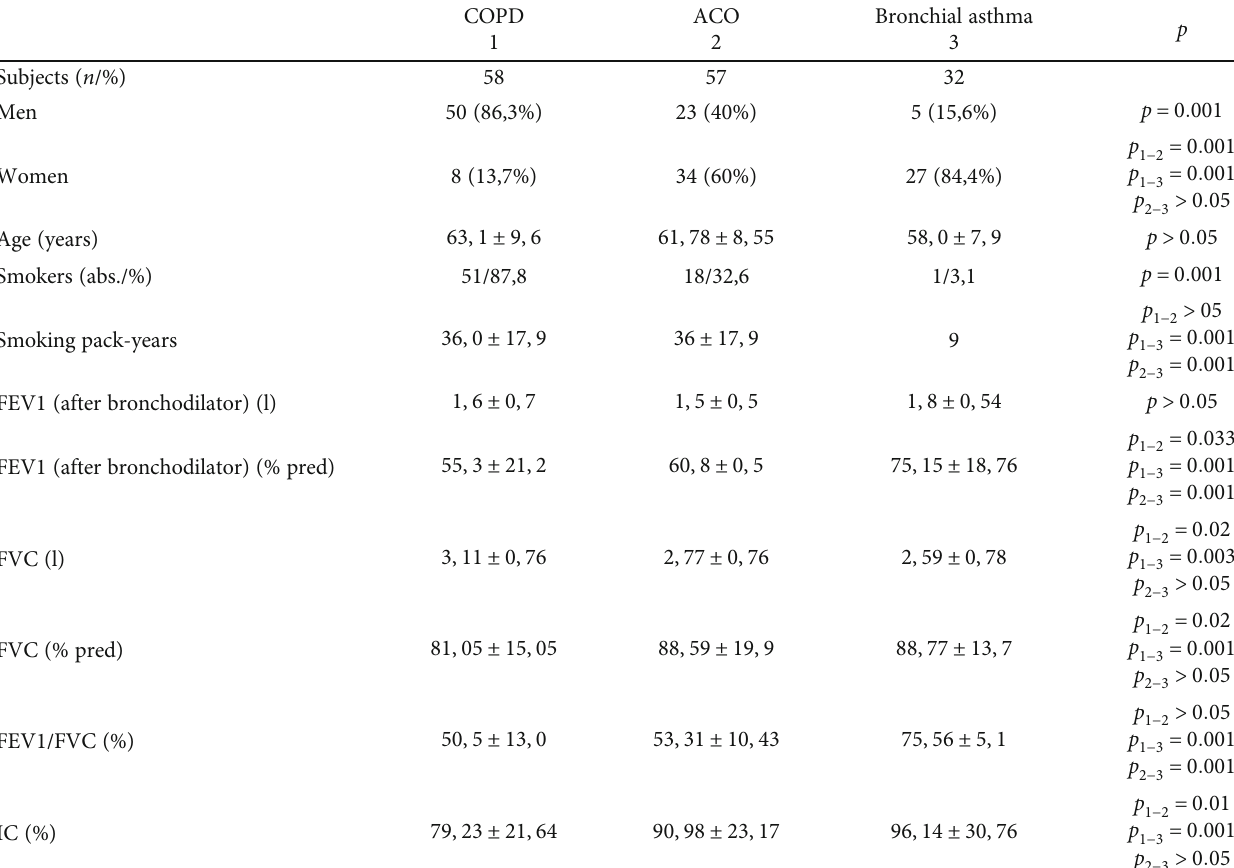
Table 1: Clinical characteristics of the examined patients with COPD, asthma-COPD overlap, and bronchial asthma. COPD